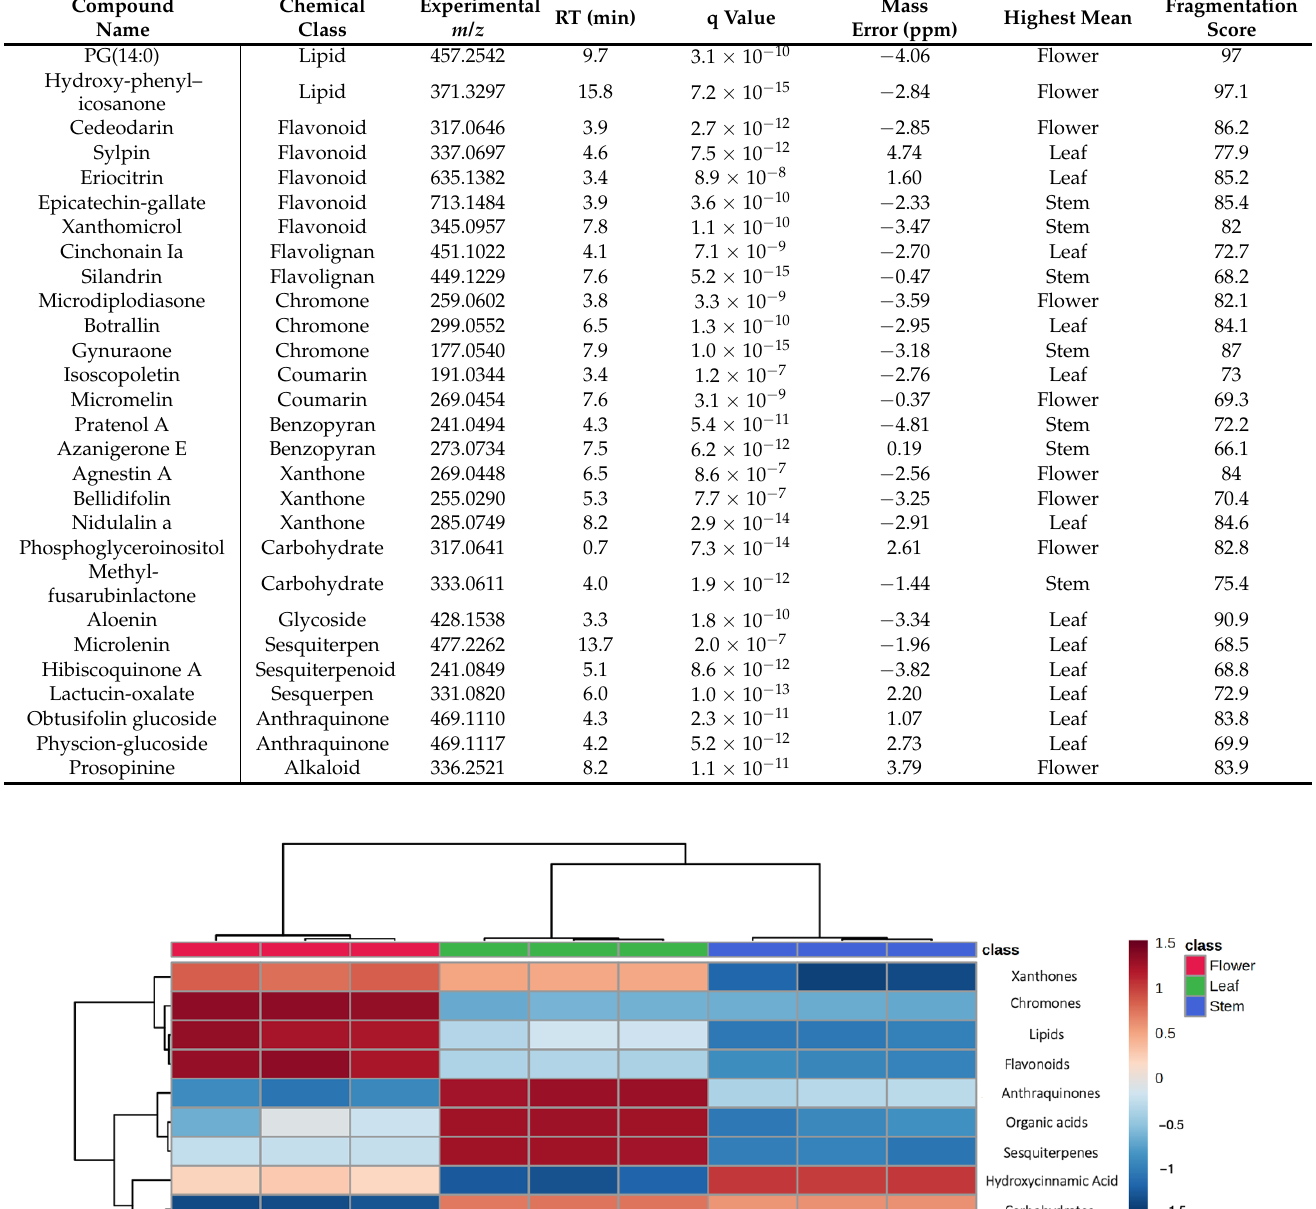
Table 1. Summarized table of the significant identified metabolites with their statistical values.